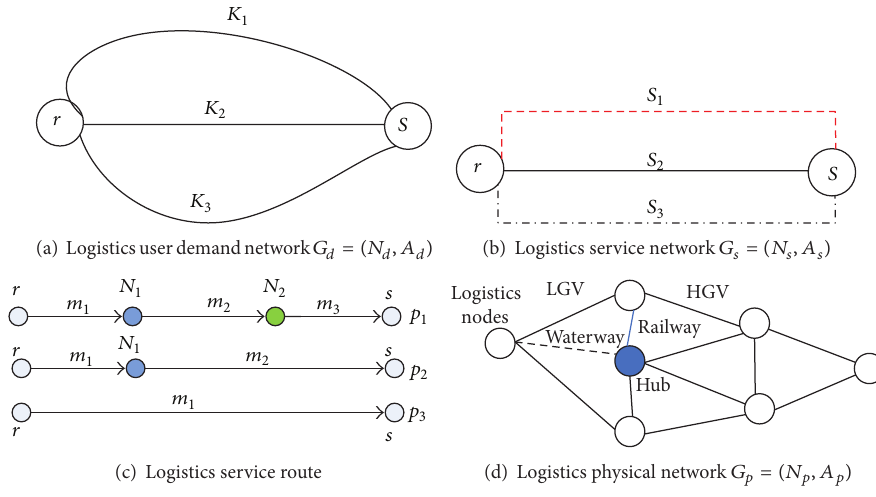
Figure 2: Network representation of the regional logistics system.